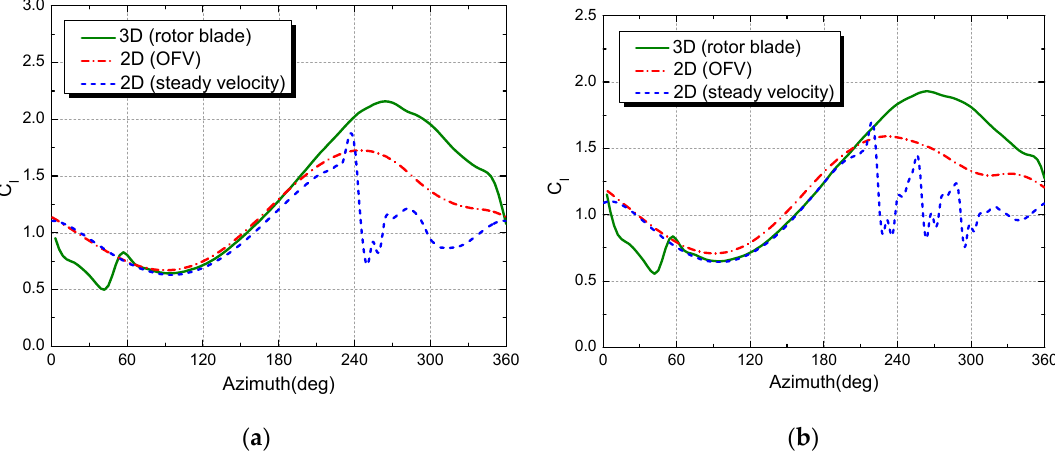
Figure 8. Comparisons of dynamic stall characteristics of airfoil between the 2D and 3D conditions. ( a ) Section of 0.6 R. ( b ) Section of 0.7 R.